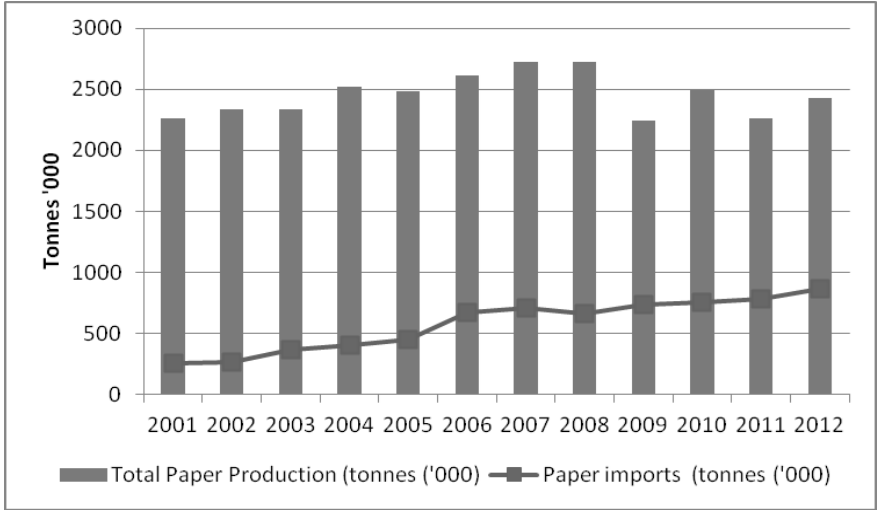
FIGURE 2: Trends of total paper production and imports Source: Derived from PAMSA,